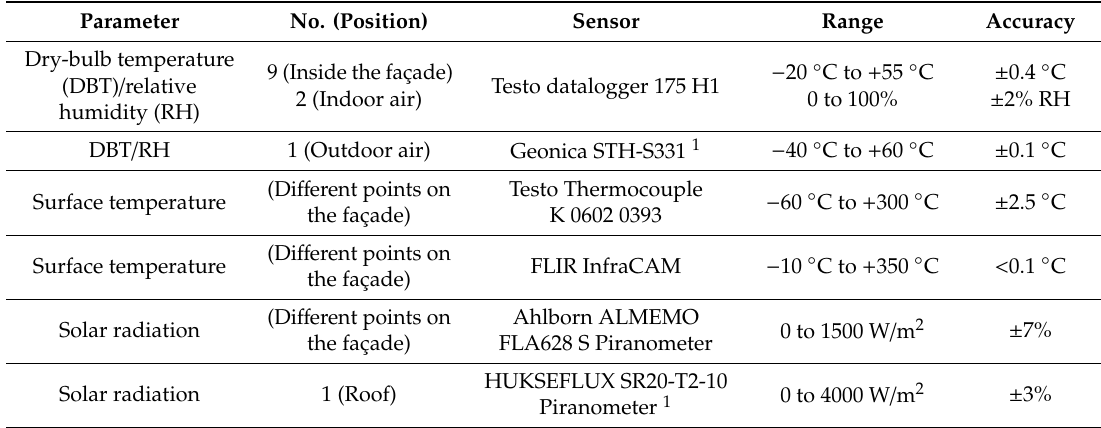
Table 1. Measurements performed, sensors and